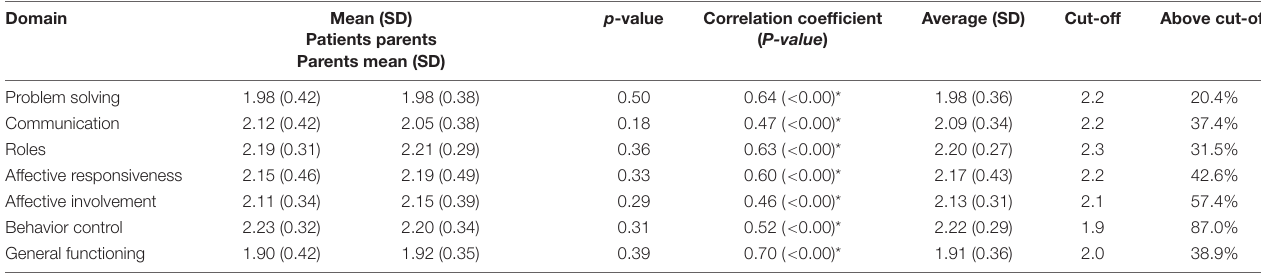
TABLE 1 | The summarization of 7 FAD domains in AIS family. Domain Mean (SD)